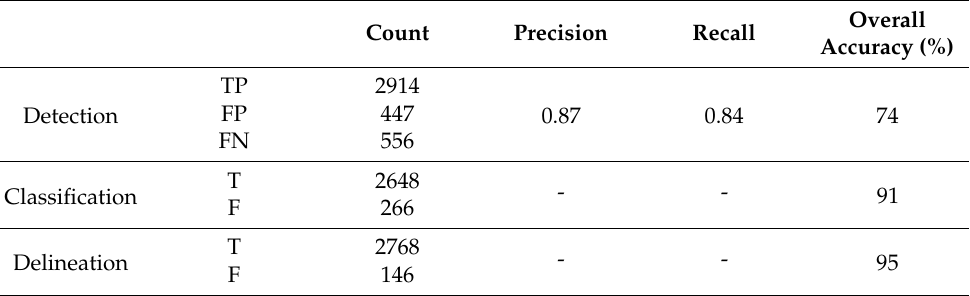
Table 2. Accuracy assessment for original images (0.6